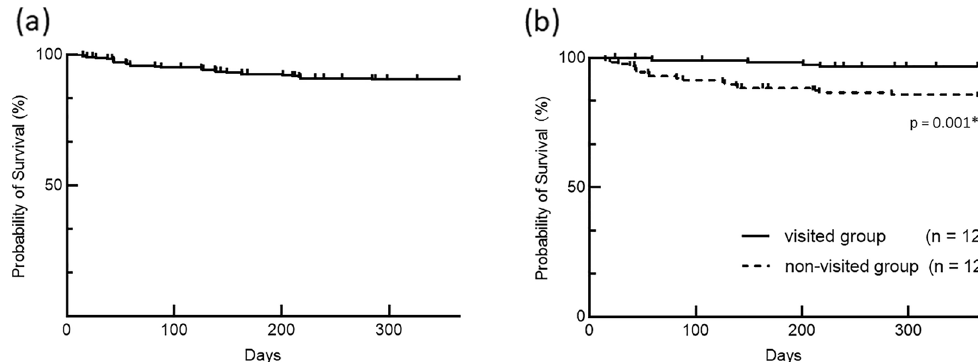
Figure 2. ( a ) Survival rate in all patients. The survival rate after initiation of dialysis was 89.3%. ( b ) Survival rates in the visited and non-visited groups were 96.7% and 84.5%, respectively. The mortality rate was significantly higher in the non-visited group than in the visited group. (p =